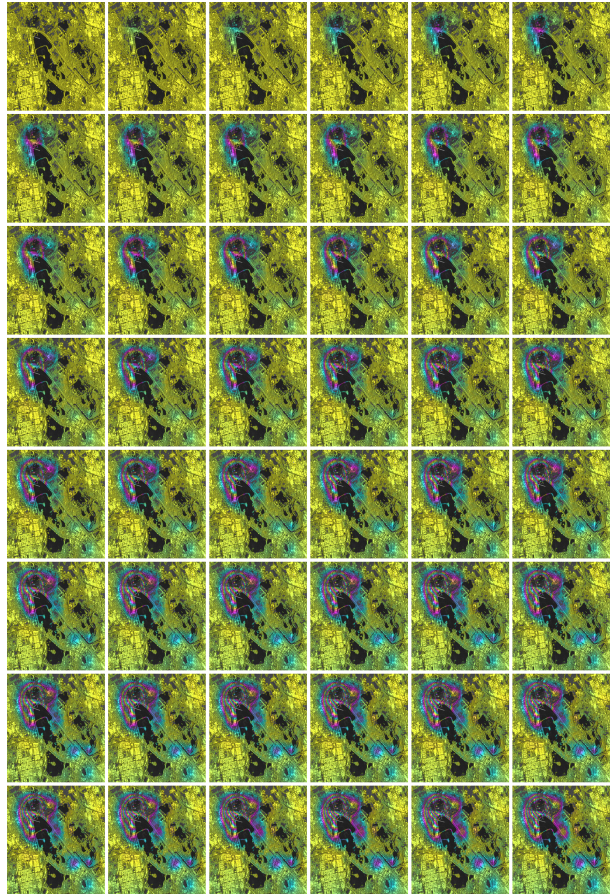
Figure 2. Deformation time series of the Nanhu mining area. (The bottom gray images are sentinel-1 radar image and superimposed color fringes present the deformation velocity, one color cycle rep- resents 20cm.)